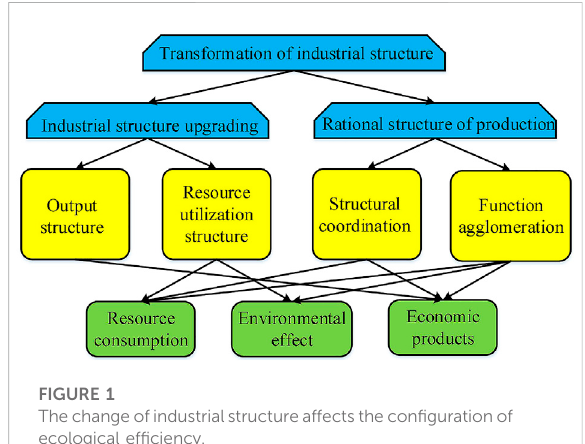
FIGURE 1 Thechangeofindustrialstructureaffectsthecon fi gurationof ecological ef fi